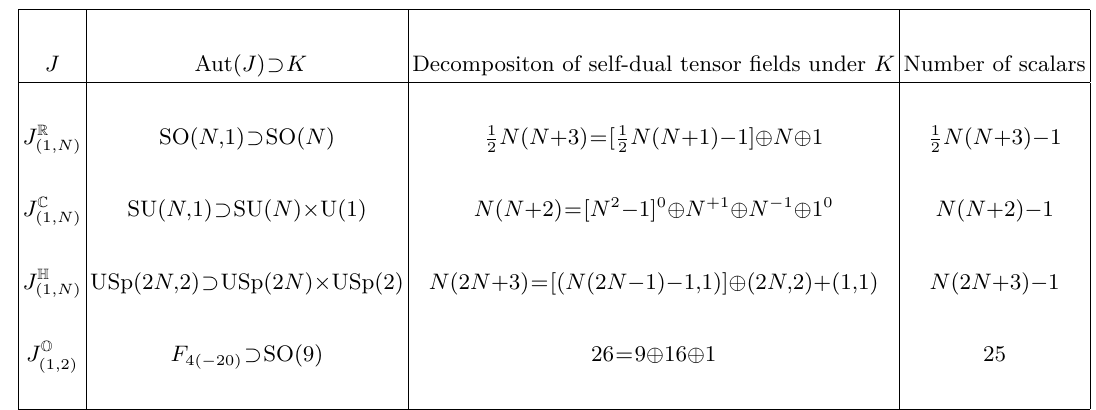
Table 4 . Unified tensor-Einstein supergravity theories in d = 6 that reduce to unified MESGTs in d = 5 defined by simple Lorentzian Jordan algebras J A whose scalar manifolds are not (1 ,N ) homogeneous spaces for N 6 = 3 . Second column lists their global symmetry groups Aut ( J A ) and (1 ,N ) their maximal compact subgroups K . Third column lists dimension of the irrep of tensor fields under Aut ( J A ) and their decomposition with respect to the maximal compact subgroup K . The (1 ,N ) last column lists the number of scalars. The theories with N = 3 have hidden larger symmetries and correspond to three of the magical supergravity theories.